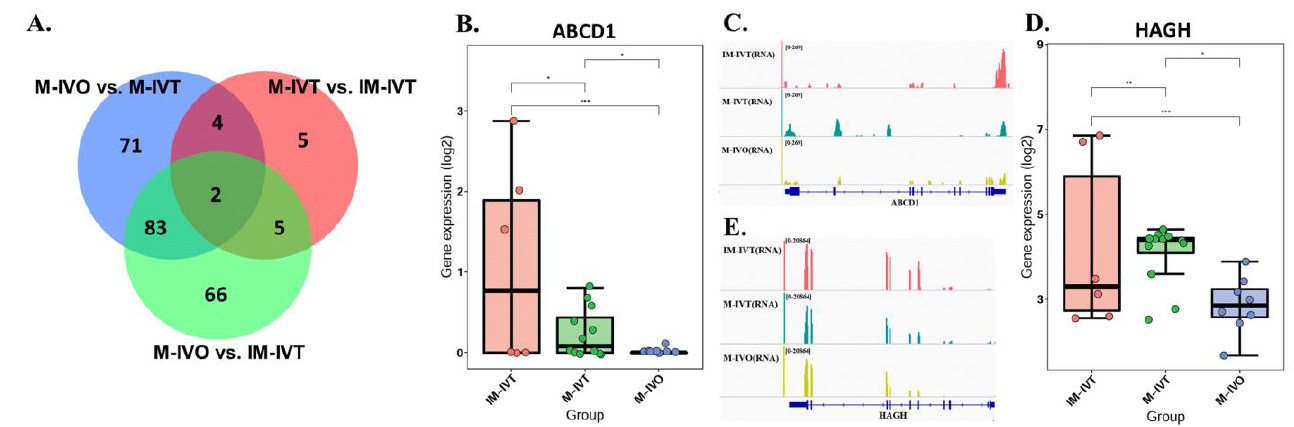
Figure 5. The common altered mitochondria-related genes in the comparisons. ( A ) Venn diagrams showing the number of mitochondria-related genes, which were overlapped within the three com- parisons. 2 overlapped mitochondria-related DEGs were present in the DEGs of the three compari- sons (M-IVO vs M-IVT comparison, M-IVT vs IM-IVT comparison, and M-IVO vs IM-IVT compari- son). 6 overlapped mitochondria-related DEGs were present in the DEGs of M-IVO vs M-IVT com- parison and M-IVT vs IM-IVT comparison. 85 overlapped mitochondria-related DEGs were present in the DEGs of M-IVT vs M-IVO comparison and M-IVO vs IM-IVT comparison. 7 overlapped mi- tochondria-related DEGs were present in the DEGs of M-IVT vs IM-IVT comparison and M-IVO vs IM-IVT comparison. 71 mitochondria-related DEGs were only present in M-IVO vs M-IVT compar- ison. 5 mitochondria-related DEGs were only present in M-IVT vs IM-IVT comparison. 66 mitochon- dria-related DEGs were only present in M-IVO vs IM-IVT comparison. The gene transcript expres- sion level in oocytes from IM-IVT group, M-IVT group and M-IVO group for ABCD1 ( B ) and HAGH ( D ). Browser view of RNA-seq signals on the gene ABCD1 ( C ) and HAGH ( E ) in IM-IVT, M-IVT and M-IVO group. The scale of normalized reads is shown for the RNA-seq data. *** p < 0.001, ** p < 0.01 and * p < 0.05 by Wilcoxon test (B and D). Abbreviation: ABCD1, ATP binding cassette subfamily D member 1; HAGH, hydroxyacylglutathione hydrolase.